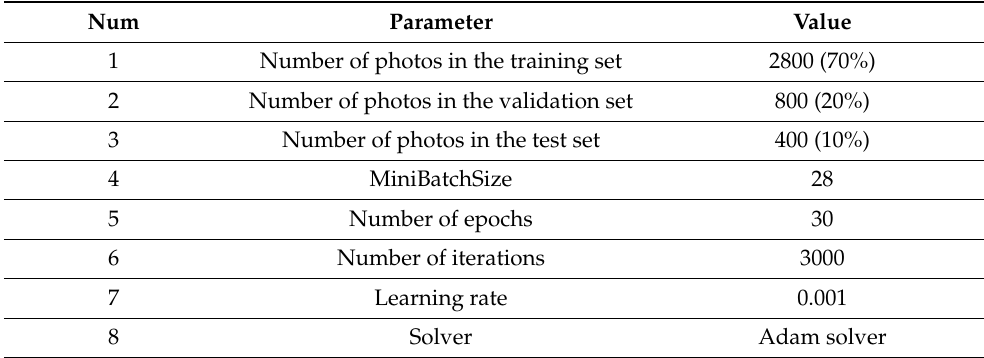
Table 1. Parameters for training the YOLOv4 convolutional neural network.